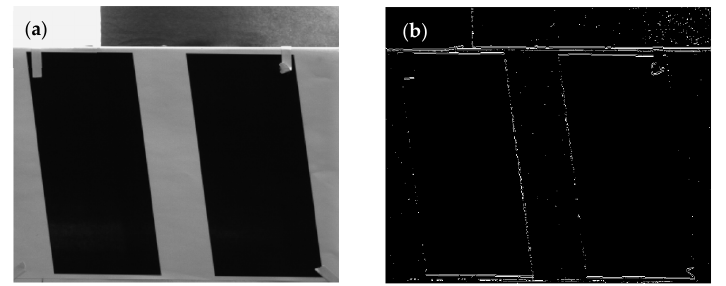
Figure 10. Experimental image processing results. ( a ) Experimental target image; ( b ) the result of subtracting edge extraction from adjacent frame images.